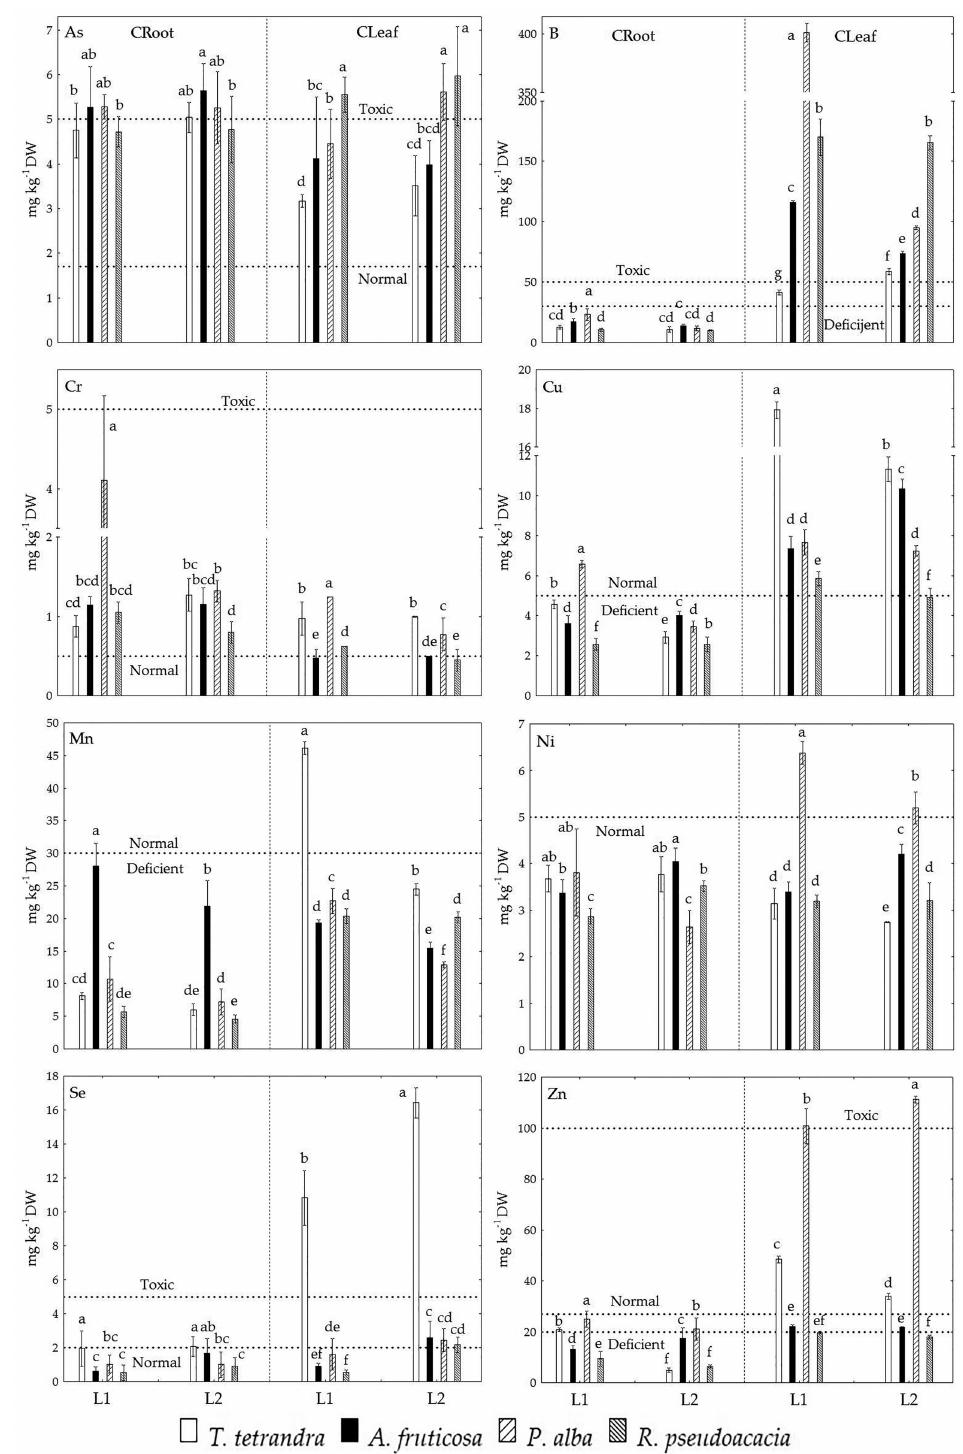
Figure 2. Total concentrations of trace elements in the roots (CRoot) and leaves (CLeaf) of four woody plant species growing at the examined sites (L1 and L2). DW—dry weight. Deficient concentration [45], as well as normal and toxic concentrations